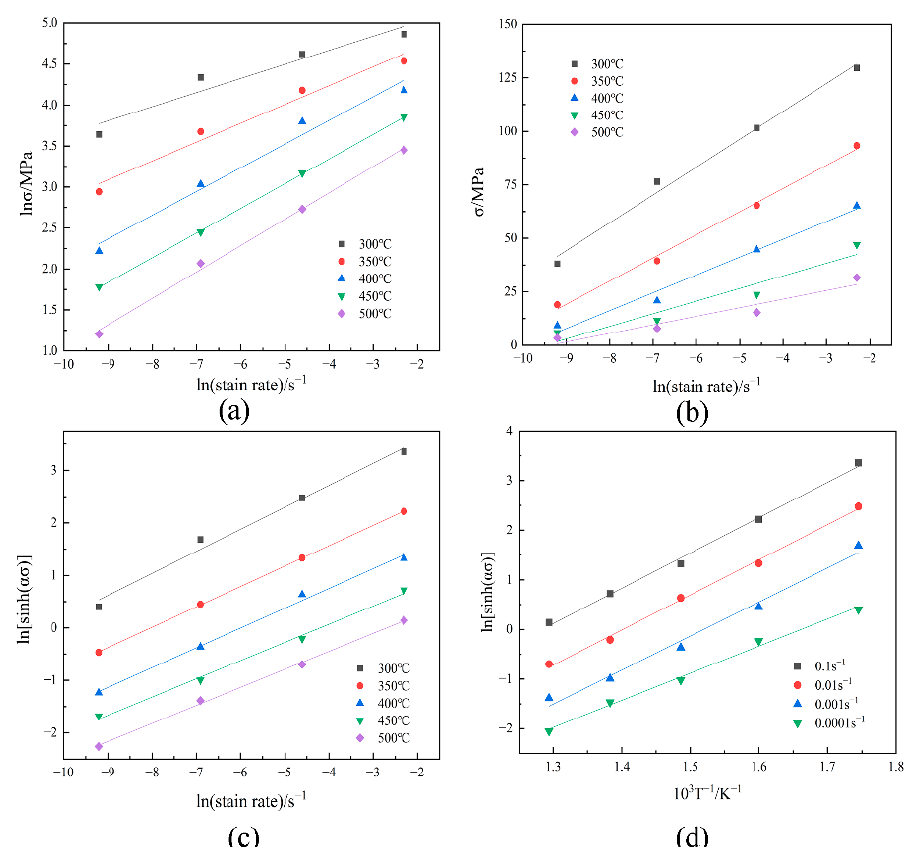
Figure 3. Linear fit to solve for material constants: ( a ) solving for n values; ( b ) solving for β values; ( c ) optimizing for n values; ( d ) solving for Q values.